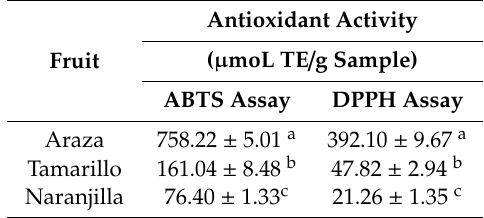
Table 6. Antioxidant activity of araza, tamarillo and naranjilla fruits using the ABTS and DPPH methods. Antioxidant Fruit